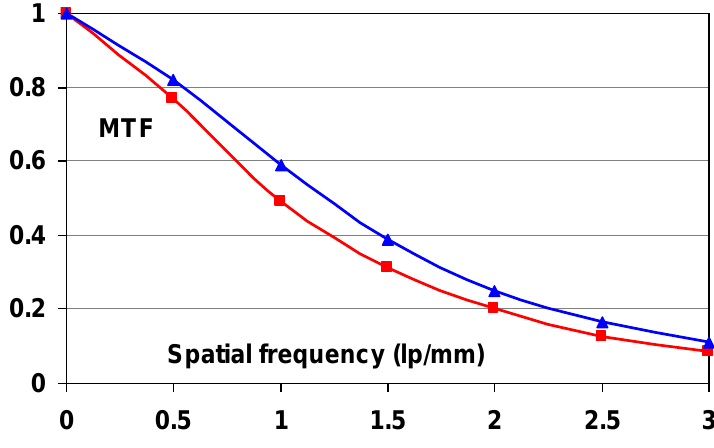
Figure 34. MTF as a function of spatial frequency for a commercial MD-30 PIP, scanned in a commercial scanner (red squares) and for a 500 μ CsBr:Eu 2+ NIP, scanned in a laboratory scanner (blue triangles) (data from